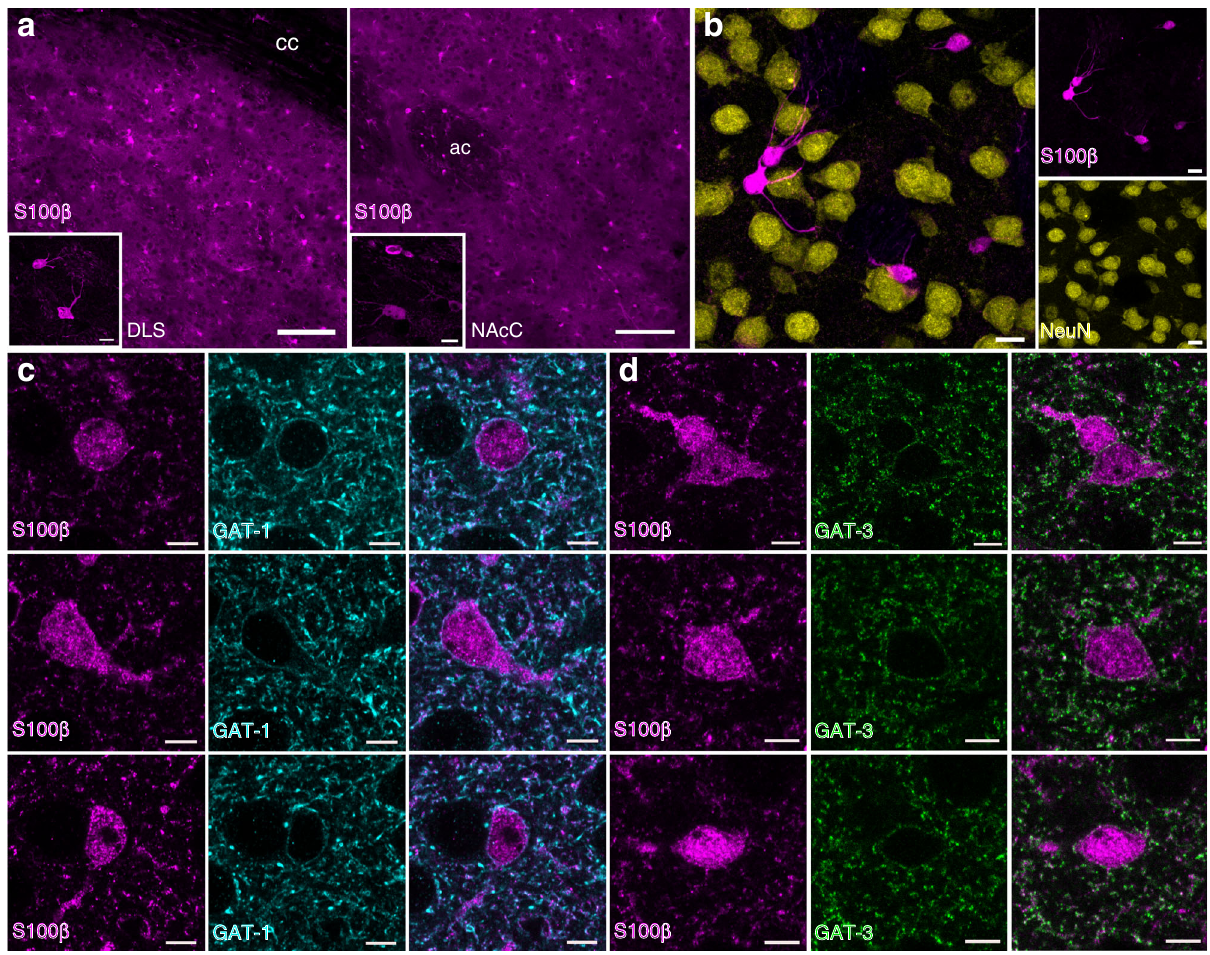
Fig. 5 GAT-1 and GAT-3 are expressed on plasma membranes of striatal astrocytes. a Striatal immuno fl uorescence signals for astrocyte marker S100 β (magenta) in dorsolateral striatum (DLS) and nucleus accumbens core (NAcC). Scale bars: 100 µ m, for inset: 10 µ m. cc corpus callosum, ac anterior commissure. b Immuno fl uorescence signals for S100 β do not colocalize with immuno fl uorescence signals for neuronal marker NeuN. Scale bars: 10 µ m. c , d GAT-1 (cyan, c ) and GAT-3 (green, d ) and are expressed on plasma membranes of striatal S100 β -expressing astrocytes imaged in DLS. Immunoreactivity for left, S100 β , centre, GAT, right, merged. Scale bars: 5 μ